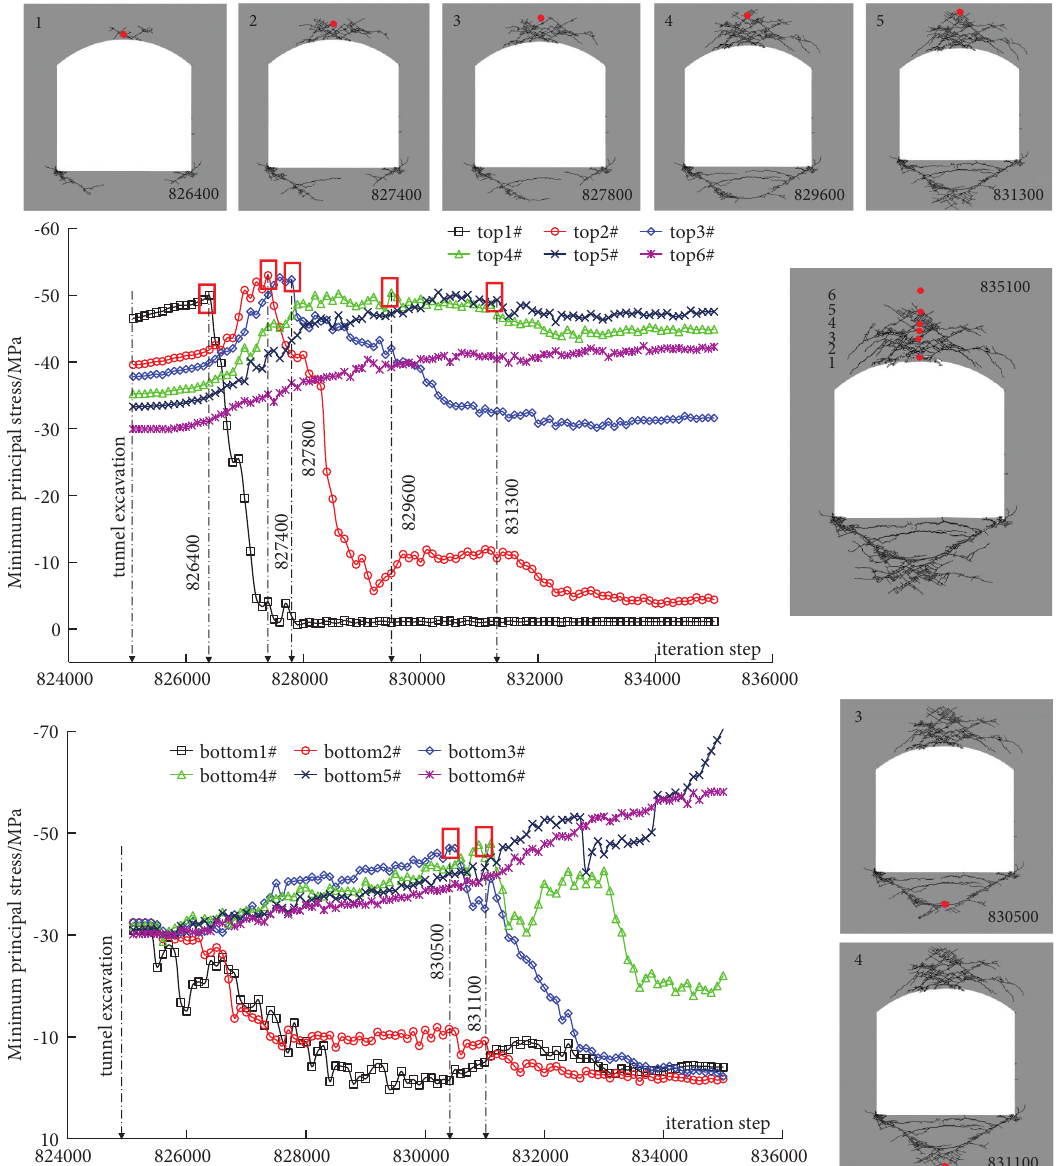
Figure 9: The principal stress curve at characteristic points of the surrounding rock